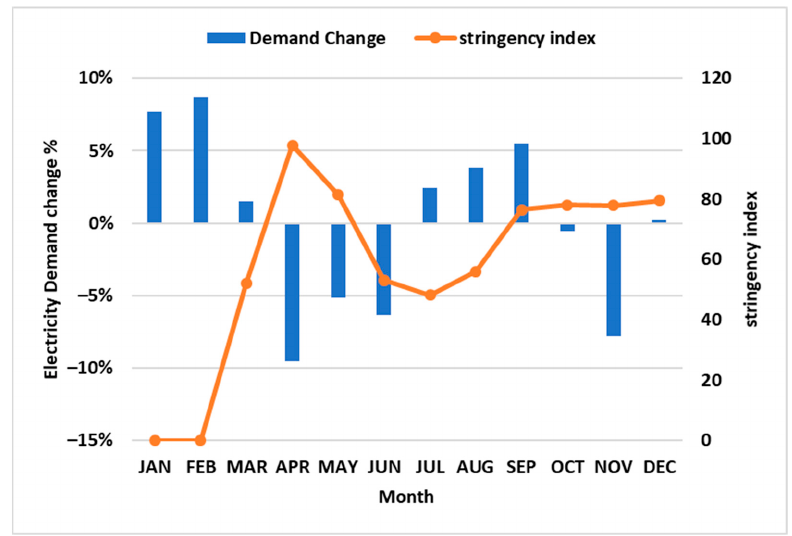
Figure 18. Monthly change in electricity demand between 2019 and 2020 in EDCO‘s area with the variation in stringency index. To account for the seasonal variations in demand, the change in consumption be- tween 2019 and 2020 by quarter is plotted in Figure 19. As can be seen from the figure that the most affected sector was the commercial and hotel sector in the second quarter, which can be attributed to the measures taken to contain the spread of COVID-19 as the southern part of Jordan receives many tourists in that part of the year.